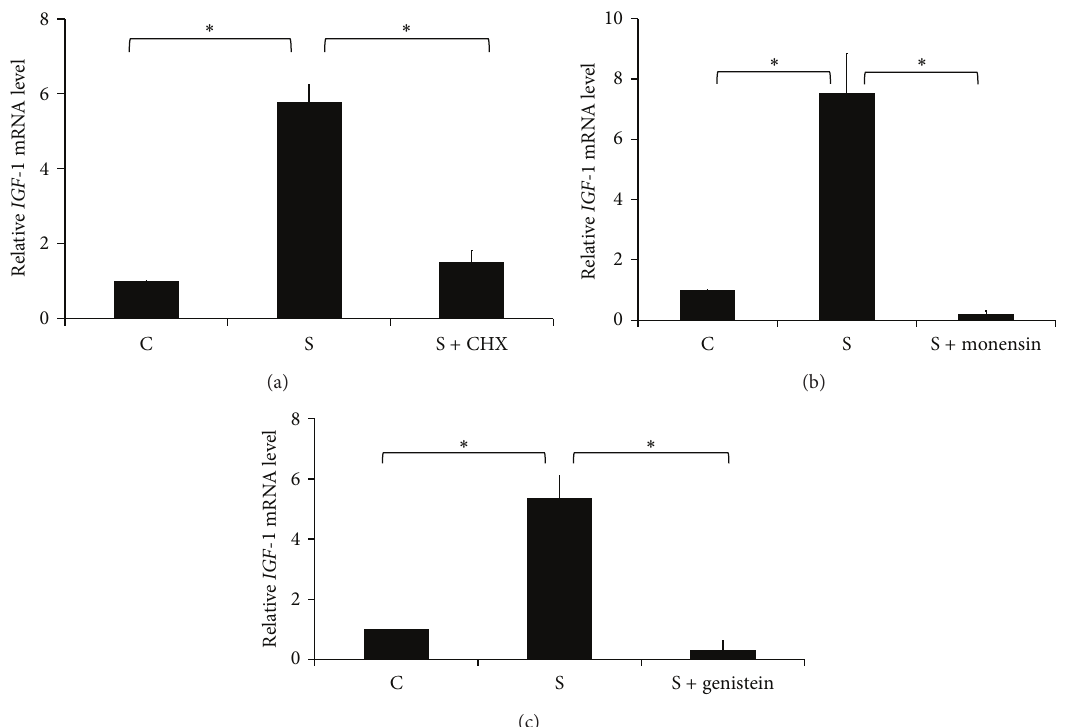
Figure 2: Intermittent mechanical stress required the intermediate protein to induce IGF-1 expression. (a) Cycloheximide (CHX; 10 𝜇 M), (b) genistein (92.5 𝜇 M), and (c) monensin (100 𝜇 M) were pretreated 30min prior to applying the intermittent mechanical stress for 24 h. IGF-1 mRNA expression was determined by real-time PCR. Asterisks indicated statistically significant difference. C: the control condition; S: the intermittent mechanical stress treatment